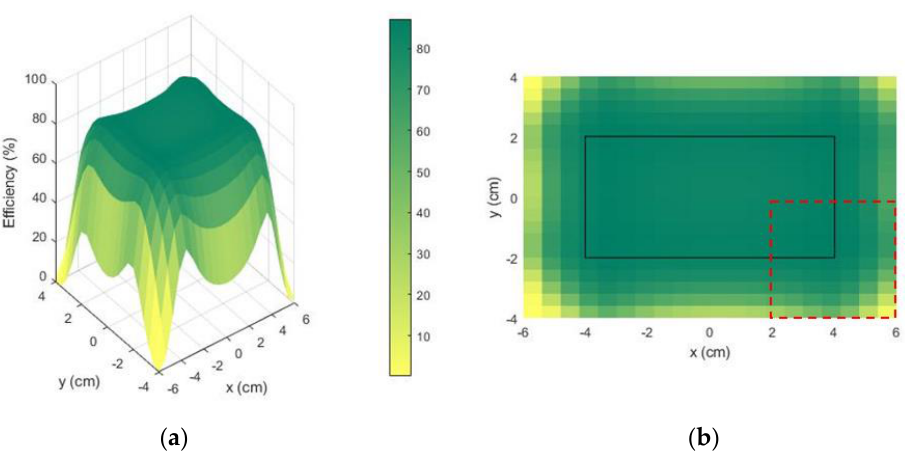
Figure 6. MATLAB ® optimization results (efficiency in %) are represented as ( a ) a 3D plot of efficiency vs. the x and y axis; ( b ) 2D plot of the efficiency seen by the top. The coordinates x and y represent the center position of the receiver. The dashed red line represents the Rx contour in an extreme position (its “center” is located at x = 4 cm and y = − 2 cm).